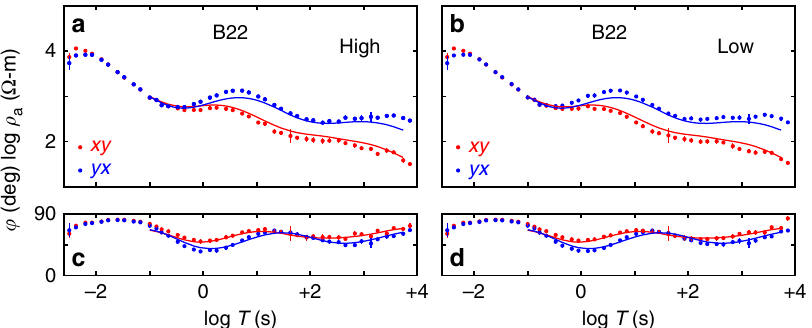
Fig. 3 Example MT responses CTAM survey area. Shown are off-diagonal apparent resistivities ρ xy and ρ yx ( a , b ) and impedance phases φ xy and φ yx ( c , d ) as a function of period T at polar plateau (PPl) site B22 (Fig. 1) corresponding to high- (left) and low- (right) activity times of the diurnal geomagnetic variation signal during the seven day recording interval of January 11 through January 18, 2012. The error fl oors assigned in the non-linear 3D inversion are re fl ected in the error bars, and are similar to the data symbol heights. The computed ρ a and φ responses from the inversion model of Fig. 6 are plotted